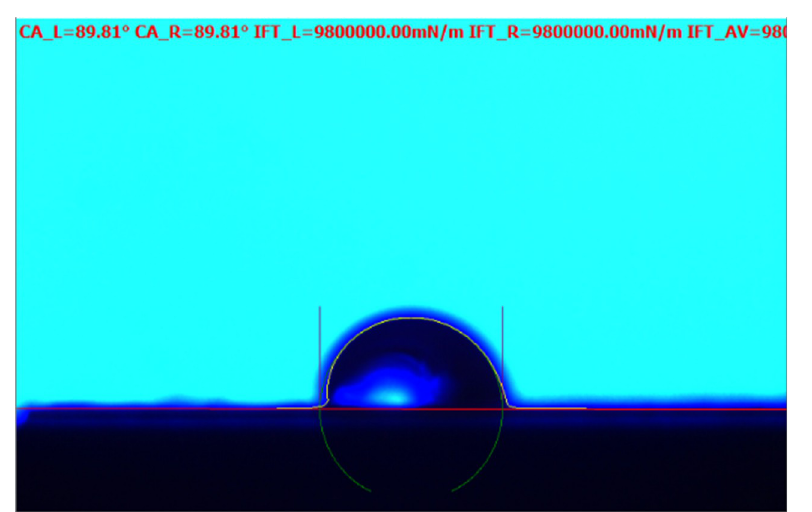
Fig 4. Typical image of the static contact angle